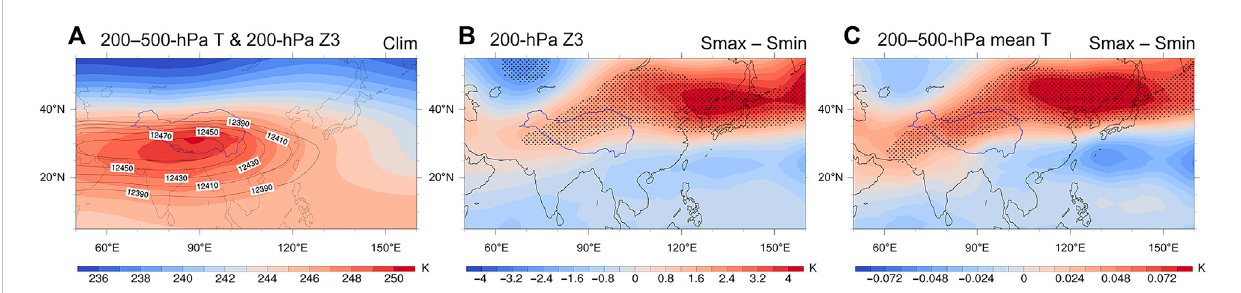
FIGURE 5 (A) Climatological JJA mean 200-hPa geopotential height (contours, gpm) and 200 – 500-hPa mean upper-tropospheric temperature (shading, K) during the period 1976 – 2005. (B) Composite differences in JJA mean geopotential height between the 11-year Smax and Smin phases from the ensemble-mean result of four TSI experiments in the CESM ‒ LME. (C) Same as (B) , but for 200 – 500-hPa mean upper-tropospheric temperature (K). The black dots denote signi fi cance at the 90% con fi dence level (two-tailed Student ’ s t -test).